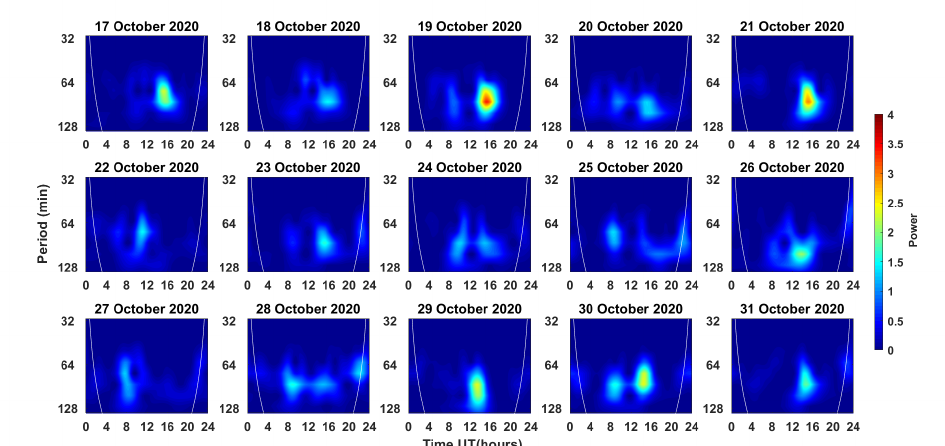
Figure 8. Scalogram from 17 to 31 October 2020 as computed from dVTEC variation for DYNG station. Along the x - and y -axis, the time (in hours) and wavelet period (in minutes) are plotted, respectively. The colorbar represents the wavelet power. The white line represents the cone of influence (COI).